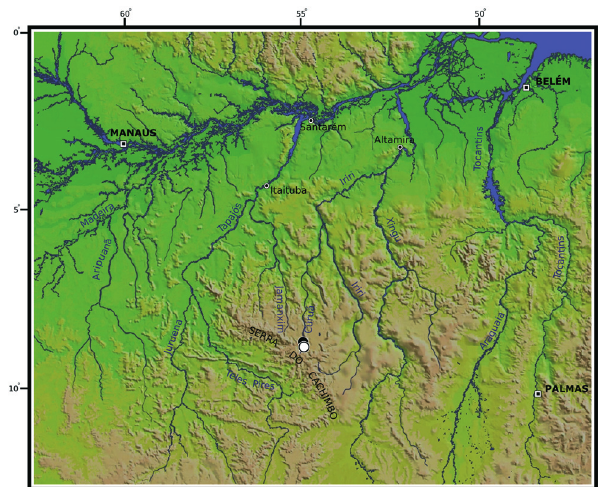
Fig. 4. Distribution of Leporinus guttatus in the rio Curuá, rio Xingu basin, central Brazil (type locality represented by open circle).